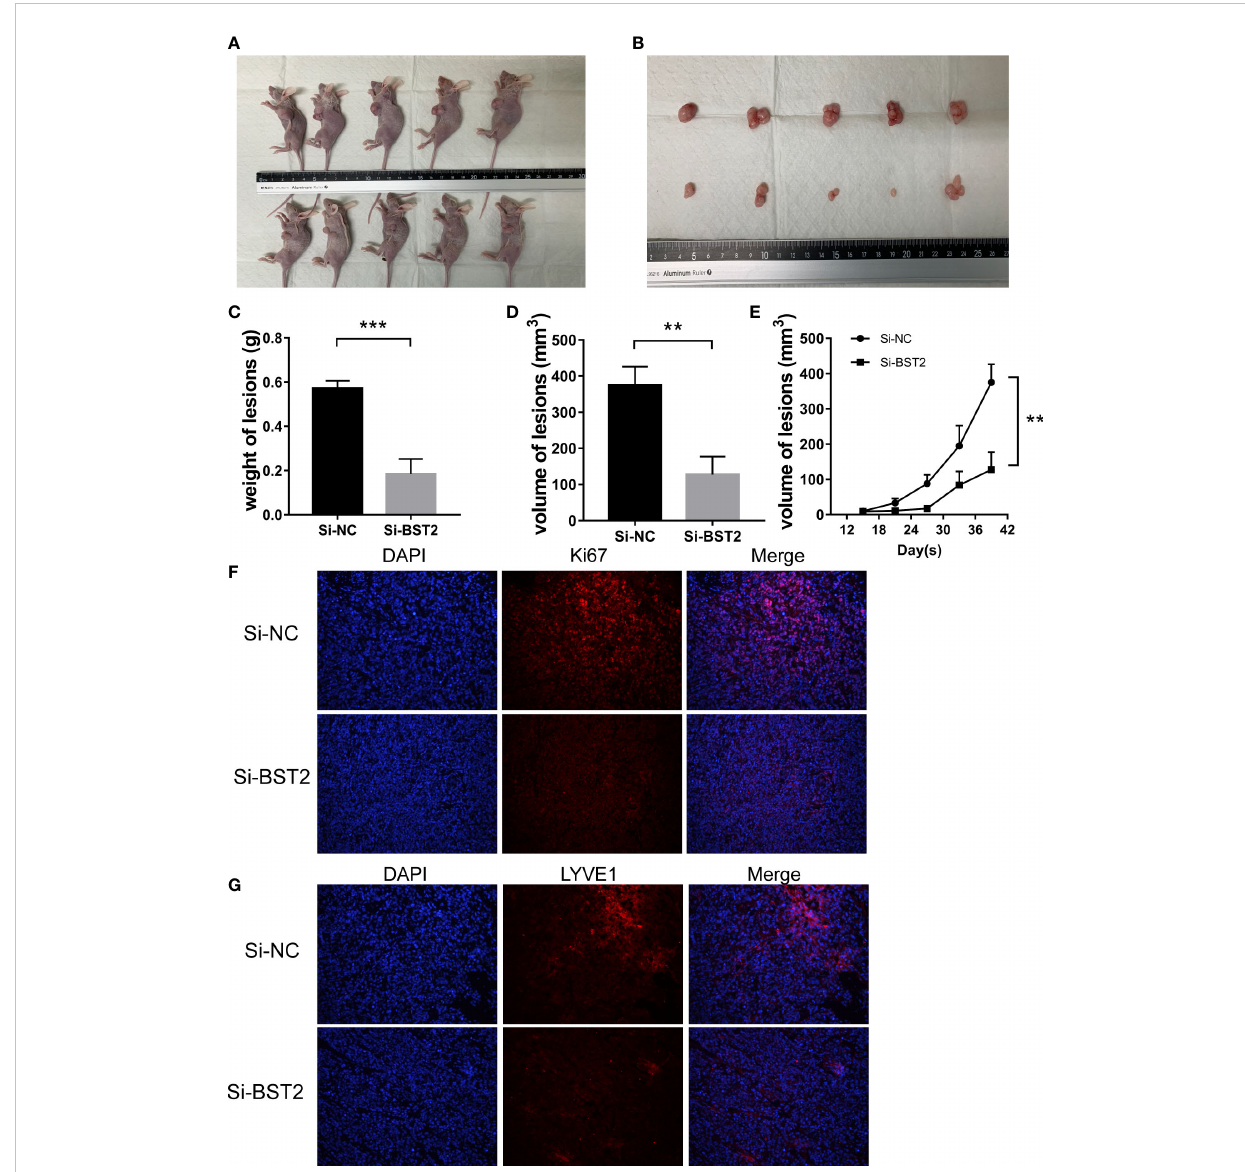
FIGURE 12 BST2 promoted the growth and lymphangiogenesis in vivo . (A, B) , The representative images offemale BALB/c nude mice after subcutaneous injection with Si-BST2 and Si-NC. (C, D) , The weight (C) and volume (D) of lesion. (E) , The volume growth curves between the Si-BST2 group and Si-NC group. (F, G) , The representative images of Immuno fl uorescence showing the proliferation and lymphangiogenesis markers. **p < 0.01; ***p <